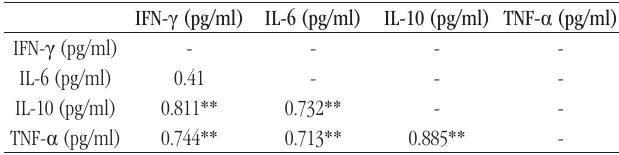
taBLE 4 − Correlation among inflammatory cytokines in type 1 diabetes patients with neuropathy